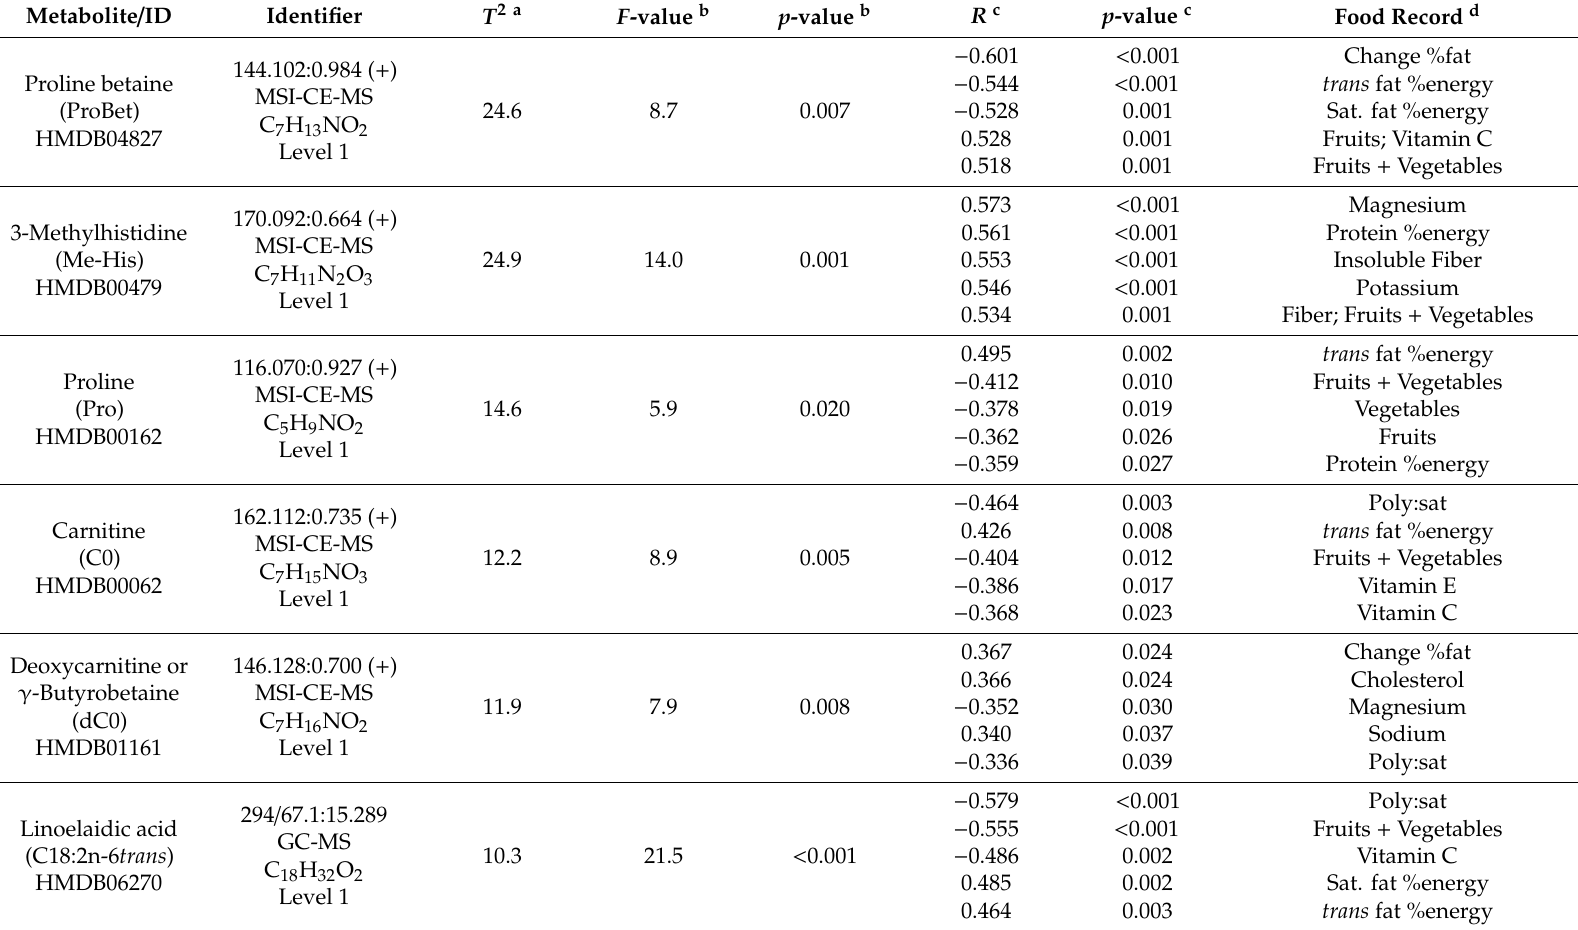
Table 2. Top-ranked plasma metabolites associated with contrasting diets by DIGEST participants ( n = 42) when using time series MEBA, mixed ANOVA, and partial correlation analysis.